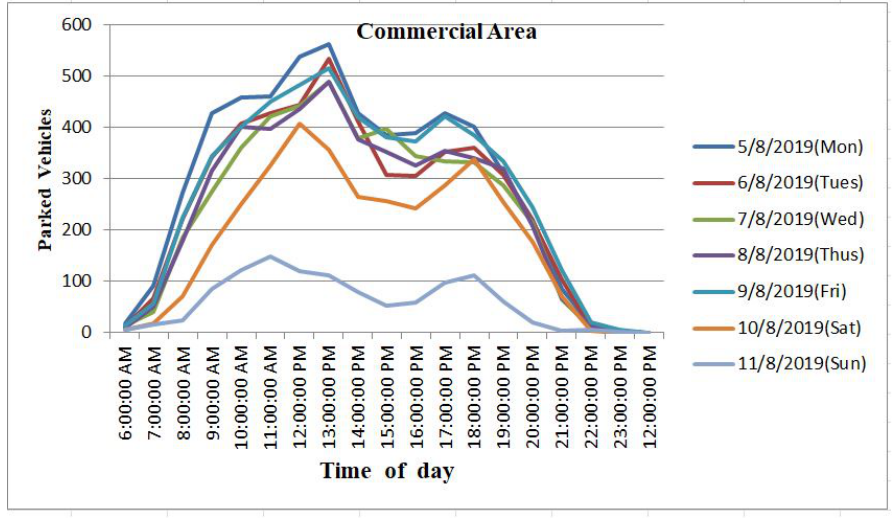
Figure 9. Commercial area traffic.